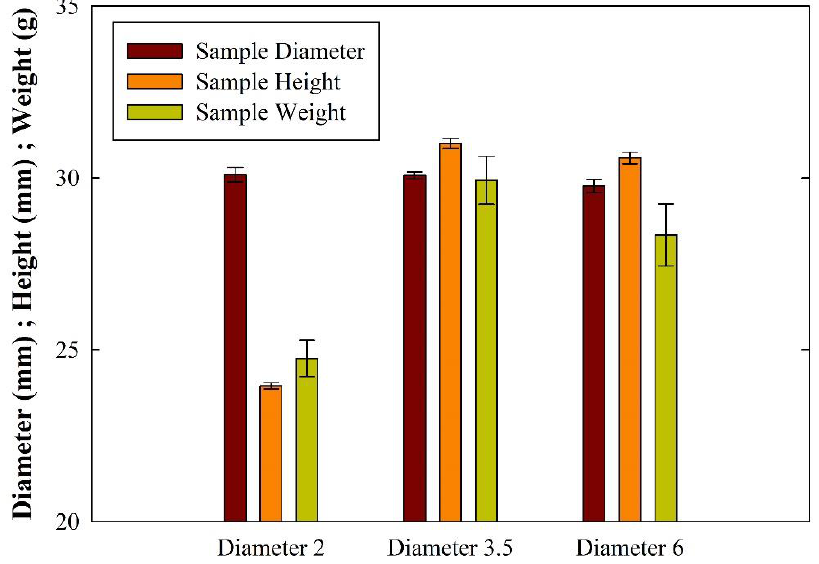
Figure 4. Produced sample dimensions.